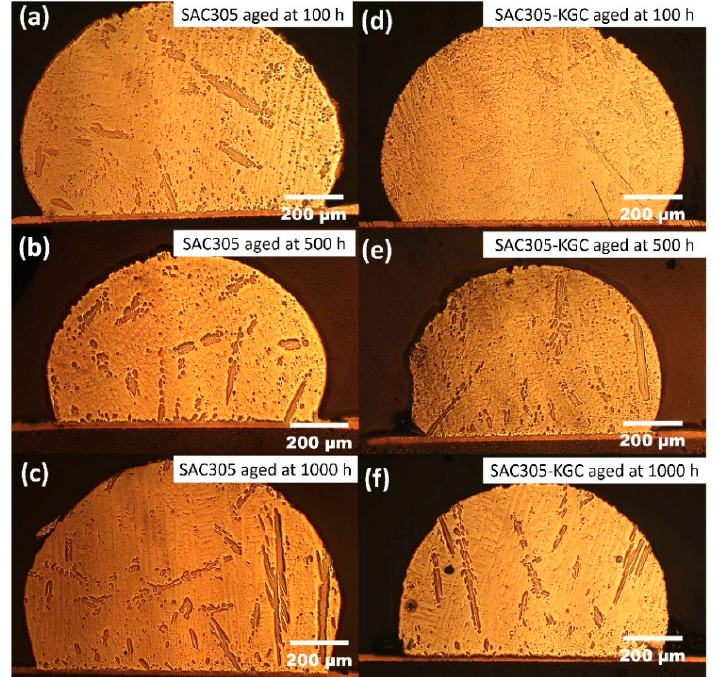
Figure 4. Microstructure formation at the bulk solder after isothermal ageing at 150 °C. Non- reinforced SAC305 solder at ( a ) 100 h, ( b ) 500 h, ( c ) 1000 h and SAC305-KGC composite solder at ( d ) 100 h, ( e ) 500 h, ( f ) 1000 h.